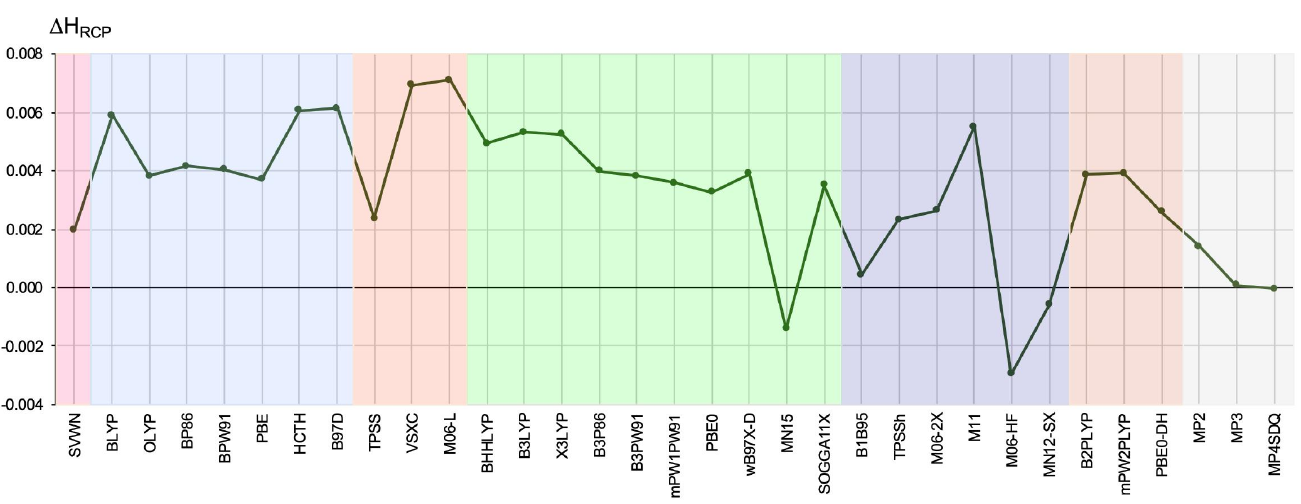
Figure 7. The difference (in relation to the CCSD method) in the value (in a.u.) of the total electronic energy density determined at the ring critical point of the 2,2-dichloro-1-(1H-pyrrol-2-yl)ethan-1-one molecule. The different types of methods are represented by a colored background: LDA—pink, GGA—blue, M-GGA—orangeish, H-GGA—green, HM-GGA—violet, DH-GGA—beige, perturba- tional